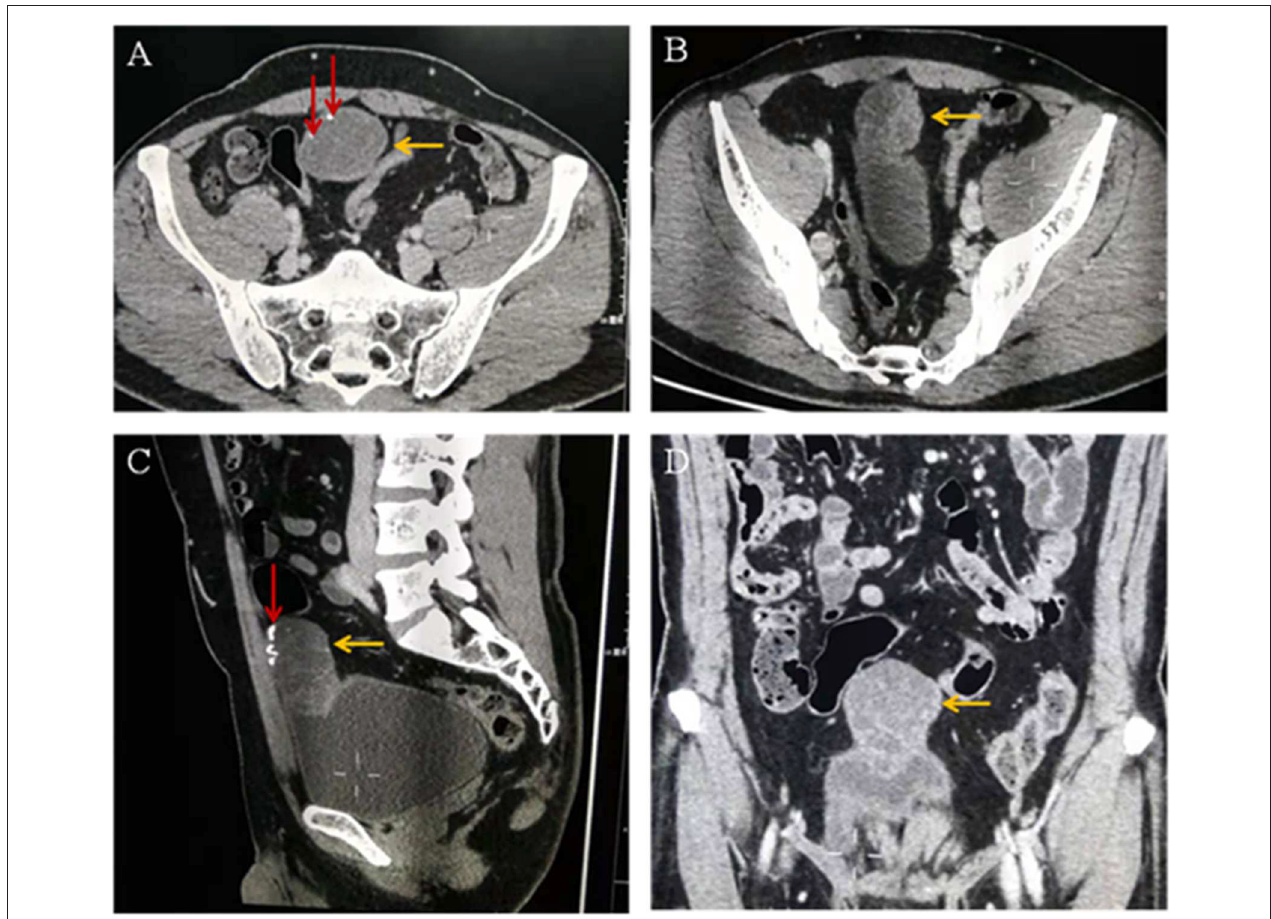
FIGURE 2 | (A–C) Computed tomographic images showing a cystic solid mass (yellow arrow) in the anterior part of the bladder measuring 6.8 × 3.9cm in size. The tumor invades the anterior wall and peritoneum of the adjacent bladder. Calcification (red arrow) and separation (yellow arrow) are visible within the tumor. (D) Enhanced computed tomographic image showing that the solid part of the mass is obviously enhanced (yellow arrow).